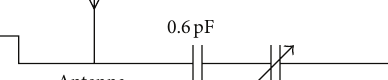
Table 5: 𝑄 comparisons at 2.400 GHz.